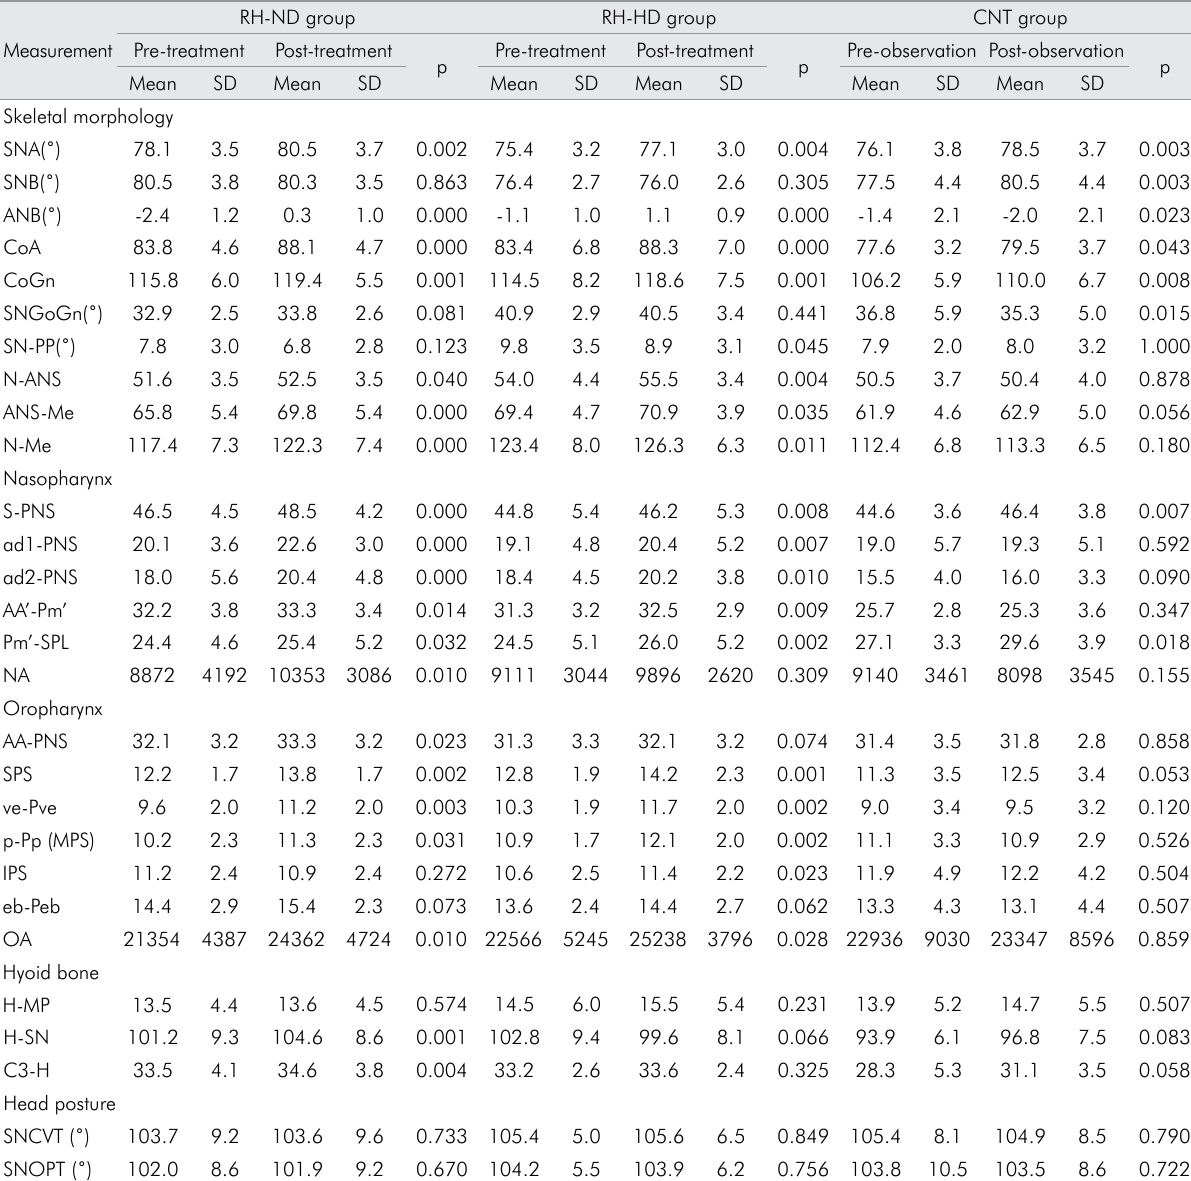
Table 1. Pre- and post-treatment and observation mean and standard deviation of variables and comparison of the changes. RH-ND group RH-HD group CNT group Measurement